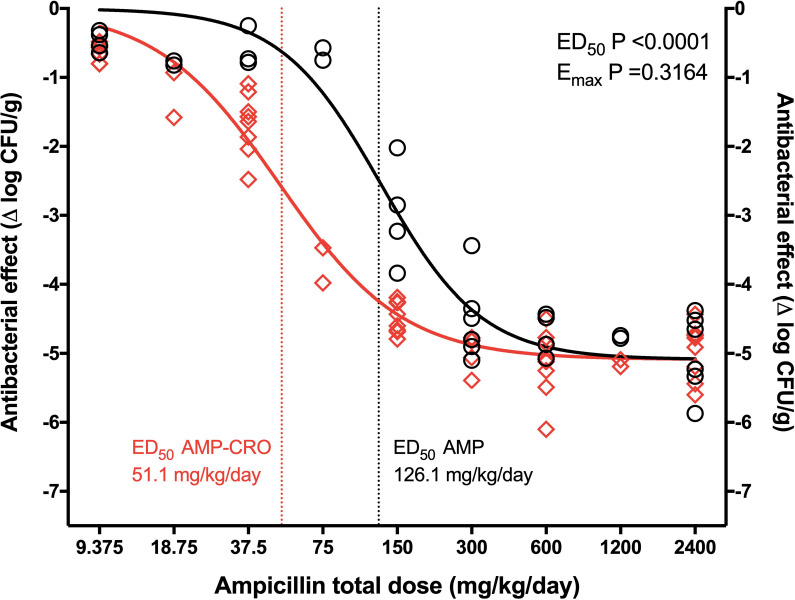
Dose-response curves of AMP monotherapy and combined AMP+CRO vs. E. faecalis ATCC 29212.AMP monotherapy (black), AMP+CRO 25, 37.5, 50 and 200 mg/kg/day combined in a single regression (red). There was no difference in Emax but a significant 59% reduction in the ED50 with the combination, indicating potentiation.